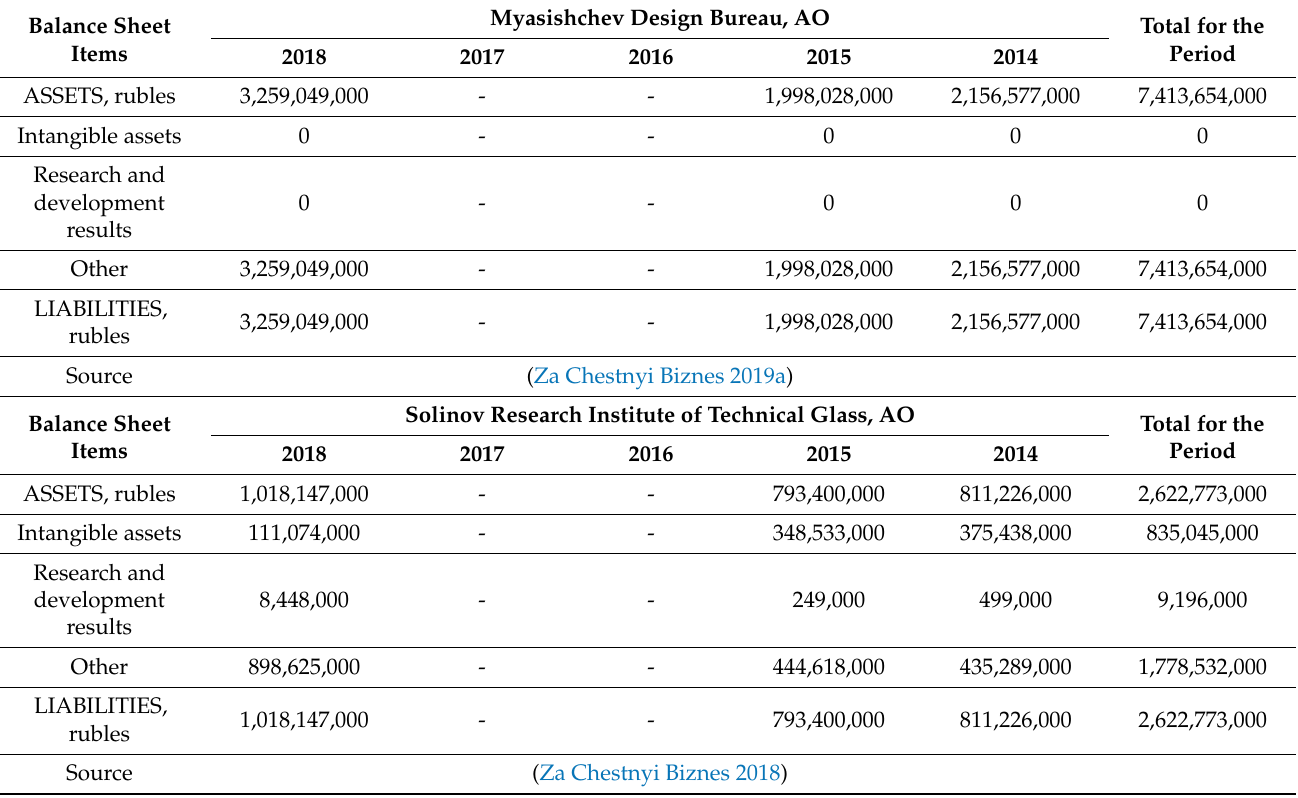
Table 4. Estimated alternative balance for a term of four years (project